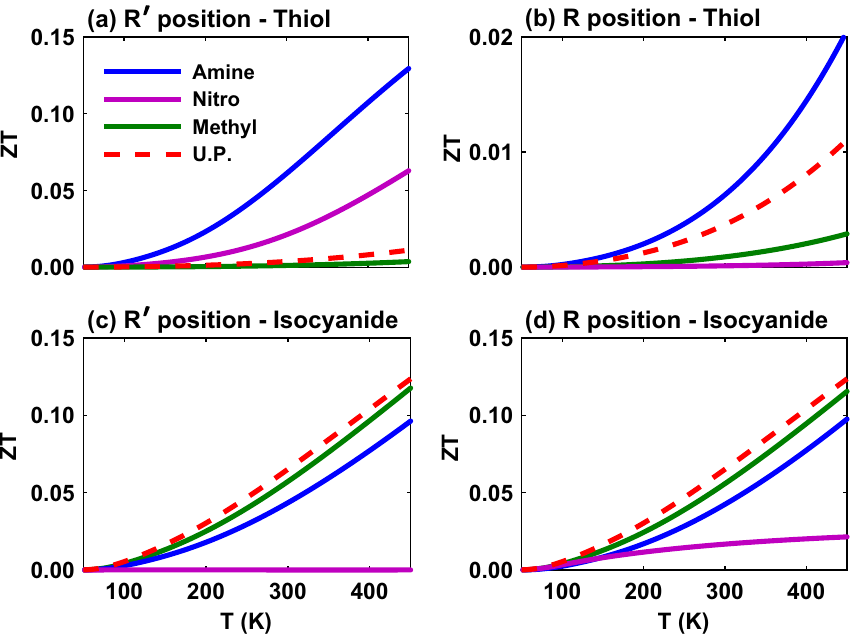
Figure 10. The figure of merit of the Au-anthracene-Au junction as a function of temperature for the thiol- terminated junction with amine (blue), nitro (magenta) or methyl (green) as the side group in ( a ) R ′ and ( b ) R positions. The electrical conductance of the isocyanide-terminated junction with amine (blue), nitro (magenta) or methyl (green) side group in ( c ) R ′ and ( d ) R positions. Furthermore, the figure of merit of the unperturbed (U.P.; red) system in the absence of side groups is drawn as a